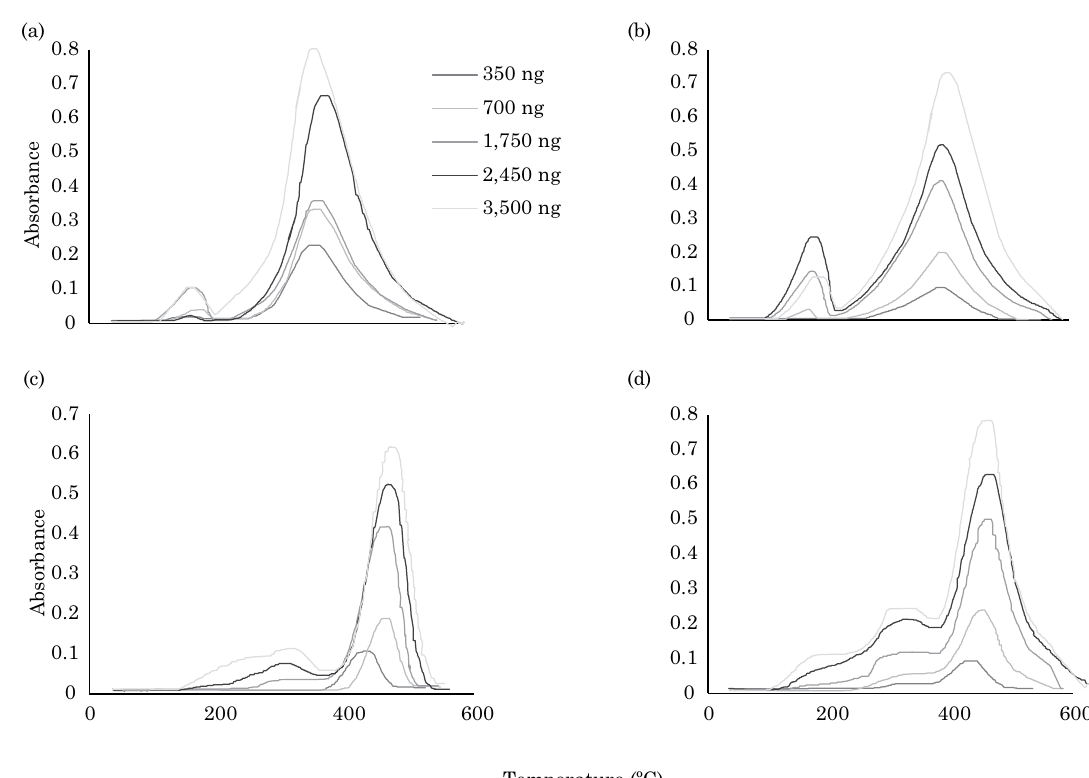
figure 2. thermograms of mercury calibration curves in soils: (a) a horizon of Quartzipsamment – rQo; (b) c horizon of Quartzipsamment – rQo; (c) b horizon of humic Xanthic hapludox – lva and (d) b horizon of oxic eutric haplustept –